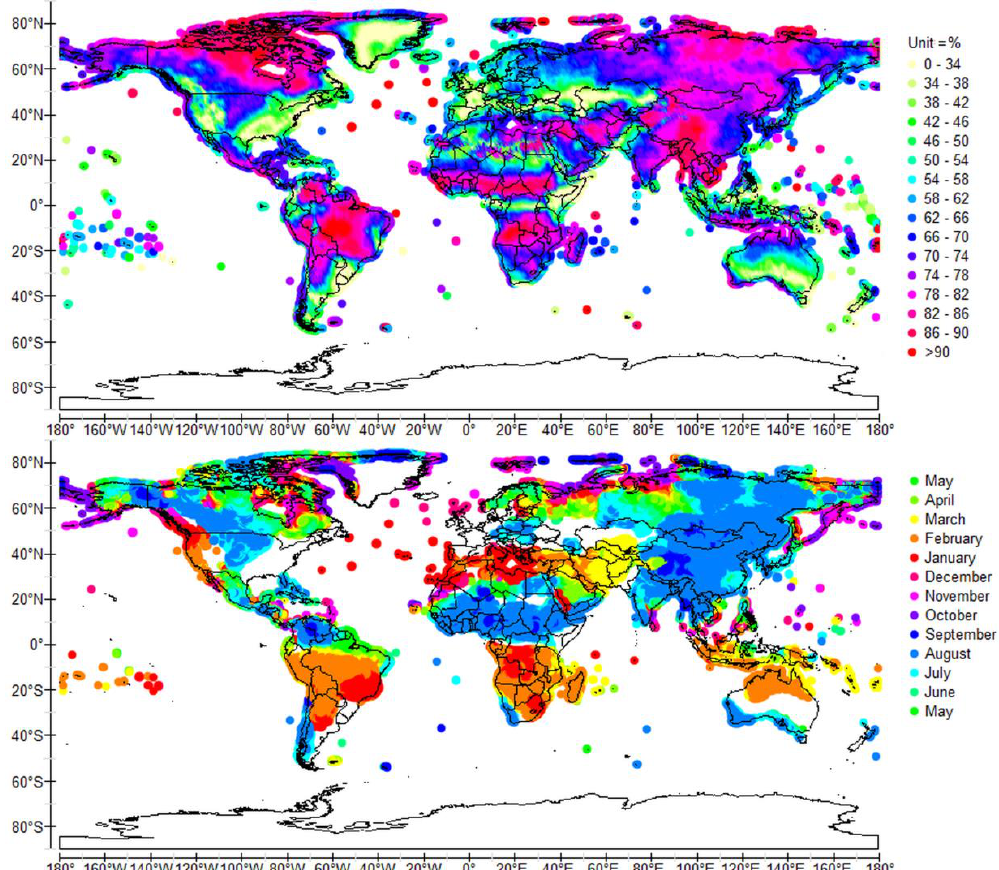
Figure 7. Cross-wavelet power ( top ) and coherence phase ( bottom ) of reduced rainfall height, scale-averaged over the 0.5–1.5-year band, time-averaged over 1901 – 2009.